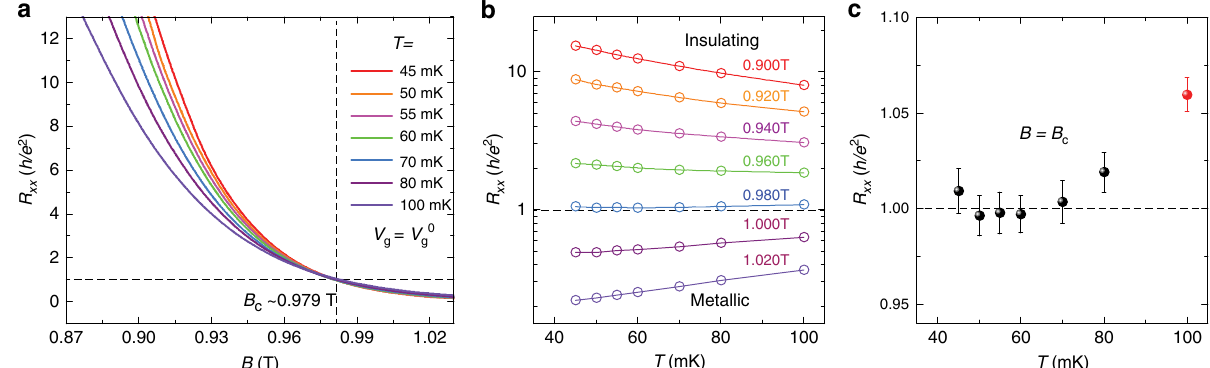
Fig. 2 Temperature evolution of the QAH insulator to axion insulator transition. a Magnetic fi eld dependence of R xx at various temperatures. All curves cross at one critical point at B c ~ 0.979 T. b Temperature dependence of R xx at different magnetic fi elds. The sample shows “ insulating ” behavior for B < B c and “ metallic ” behavior for B > B c . At B = 0.980 T, R xx is nearly independent of temperature. c R xx value at the crossing point as a function of